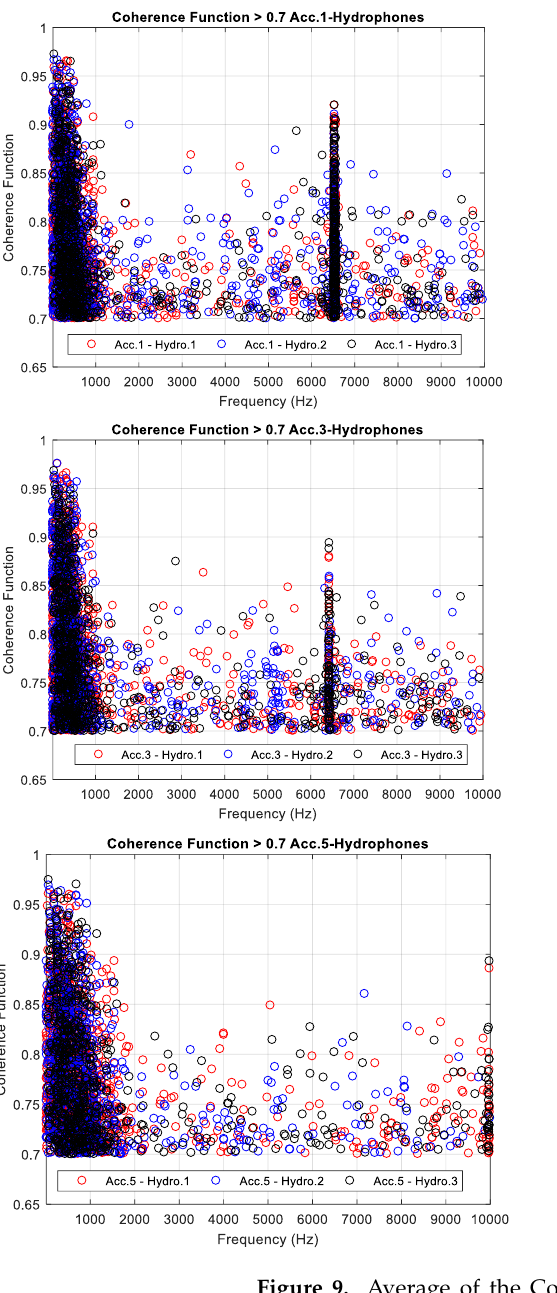
Figure 9. Average of the Coherence Function higher than 0.7 versus frequency between each hydrophone and the accelerometer 1 ( top-left ), accelerometer 2 ( top-right ), accelerometer 3 ( middle-left ), accelerometer 4 ( middle-right ) and accelerometer 5 ( bottom-left ). Description of the position of the accelerometers installed in the ship’s panel ( bottom-right ).